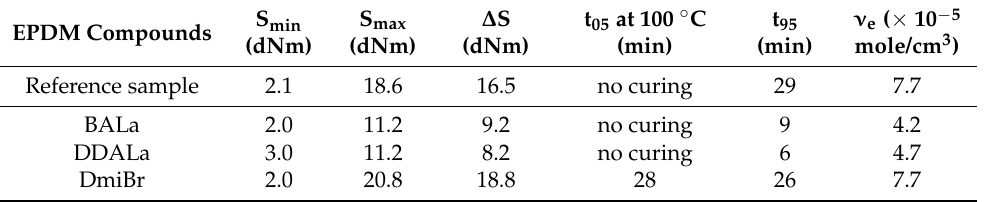
Figure 23. Rheometric curves at 150 ◦ C for EPDM compounds containing TSILs or DmiBr. Table 7. Cure characteristics of EPDM compounds at 150 ◦ C and crosslink densities of vulcan- izates with ILs ( ∆ S, torque increase; t 05 , scorch time; t 95 , optimal vulcanization time; ν e , crosslink density; standard deviations: S min ± 0.6, dNm ∆ S ± 2.9 dNm, t 05 ± 2.4 min, t 95 ± 1.6 min, ν e ± 0.9 × 10 − 5 mole/cm 3